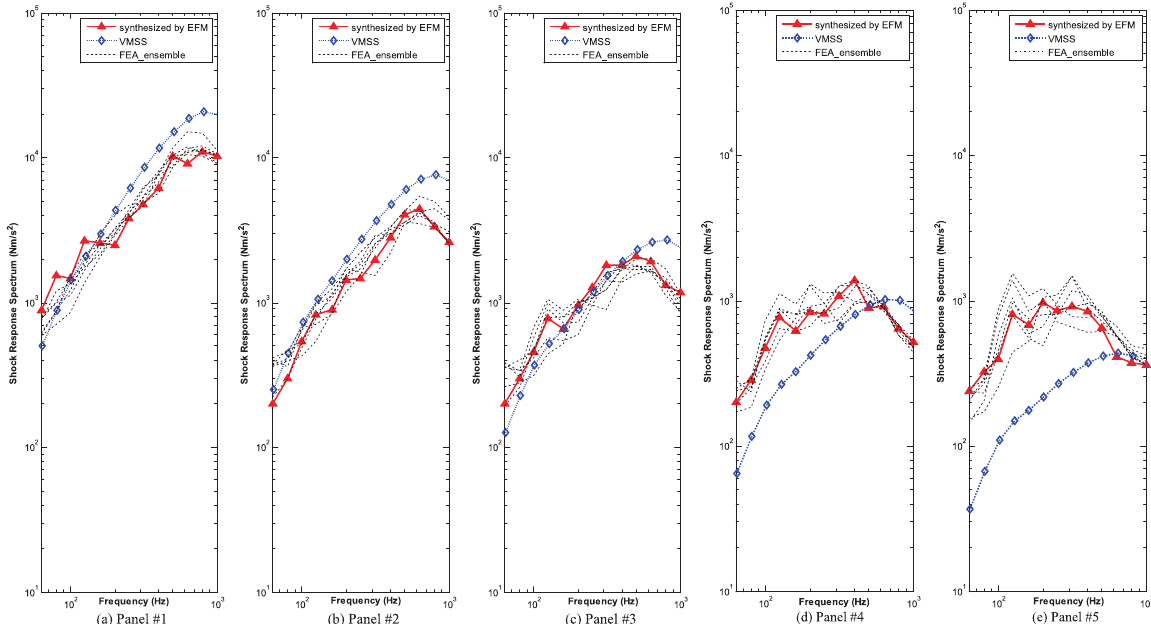
Fig. 17. SRS Comparison of the Synthesized by EFM, VMSS and FEA ensemble: for the FEA ensemble, each dotted line represents a spatial average over the SRS responses on the corresponding panel for each force input (a total of 6 inputs on panel #1 are